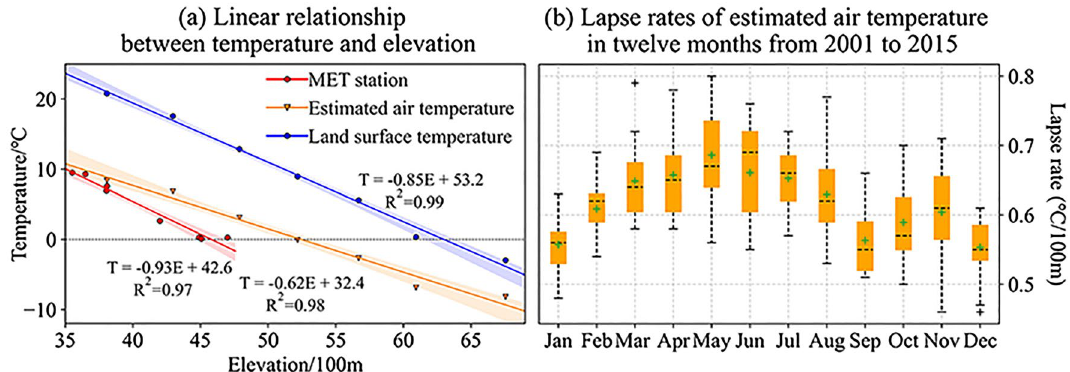
Figure 5. Relationship between elevation and different temperature datasets and variation of air temperature lapse rate in different months. In ( b) , the boxplot of each month is composed of 15 temperature lapse rates from 2001 to 2015, which were obtained by constructing the trend line between the zonal average temperature and zonal average elevation of 7 elevation zones.